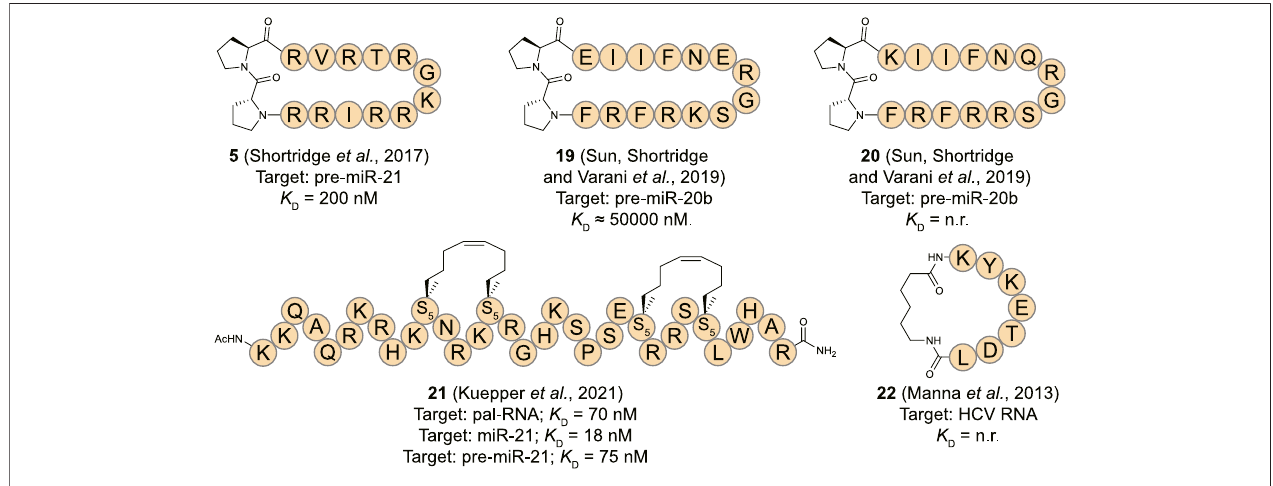
FIGURE 9 | Structures of (pre-)miRNA and viral RNA binding cyclic peptides. n. r. = not reported. S 5 = ( s